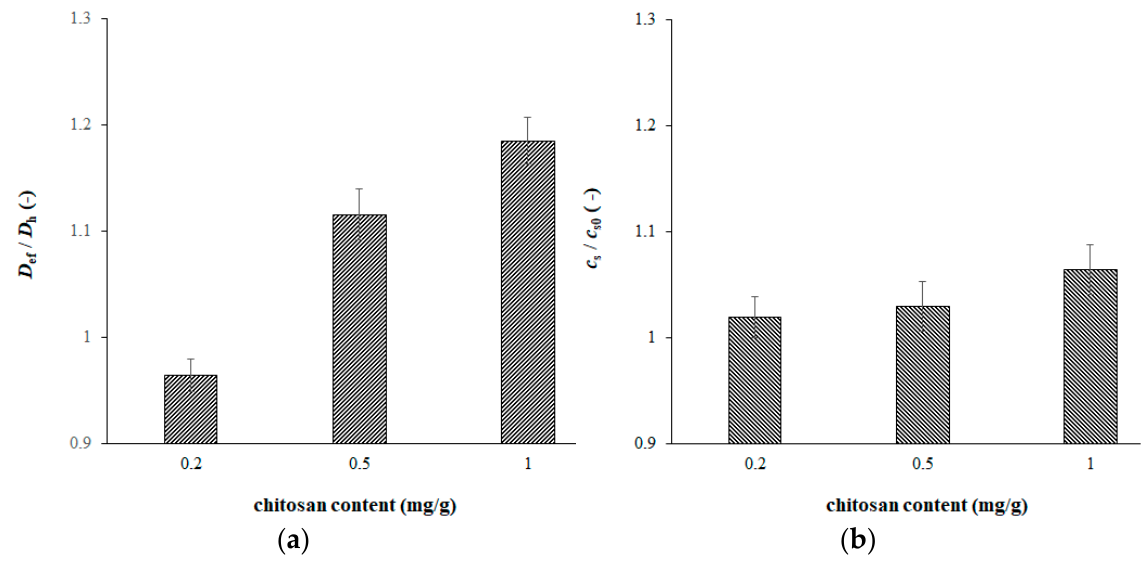
Figure 3. The ratios between effective diffusion coefficient D ef obtained for hydrogels containing chitosan and D h obtained for pure agarose hydrogel ( a ), and ratios between concentration of copper(II) ions at interface c s obtained for hydrogels containing chitosan, and c s 0 obtained for pure agarose hydrogel ( b ).